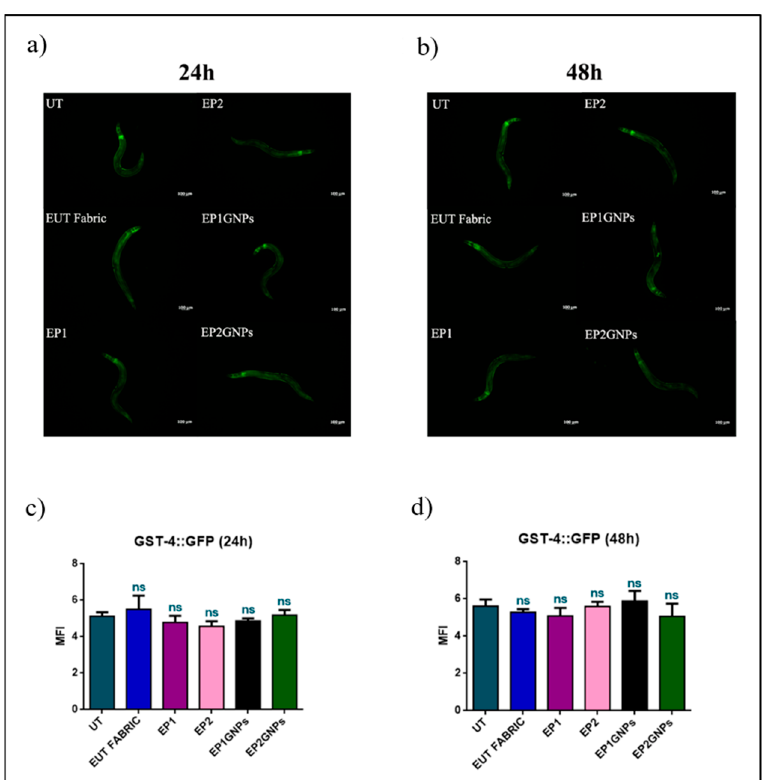
Figure 9. Fluorescence microscopy of GST4: GFP nematode strain after ( a ) 24 h and ( b ) 48 h of eluates treatment. Scale bar = 100 μ m. Quantification of fluorescence intensity of C. elegans GST4::GFP transgenic strain exposed to the different texture extracts for ( c ) 24 h and ( d ) 48 h. Mean fluorescence intensity (MFI) was obtained using ImageJ software, and data were expressed as (mean ± SD), considering at least 10 worms in each experimental group (ns: not significant).